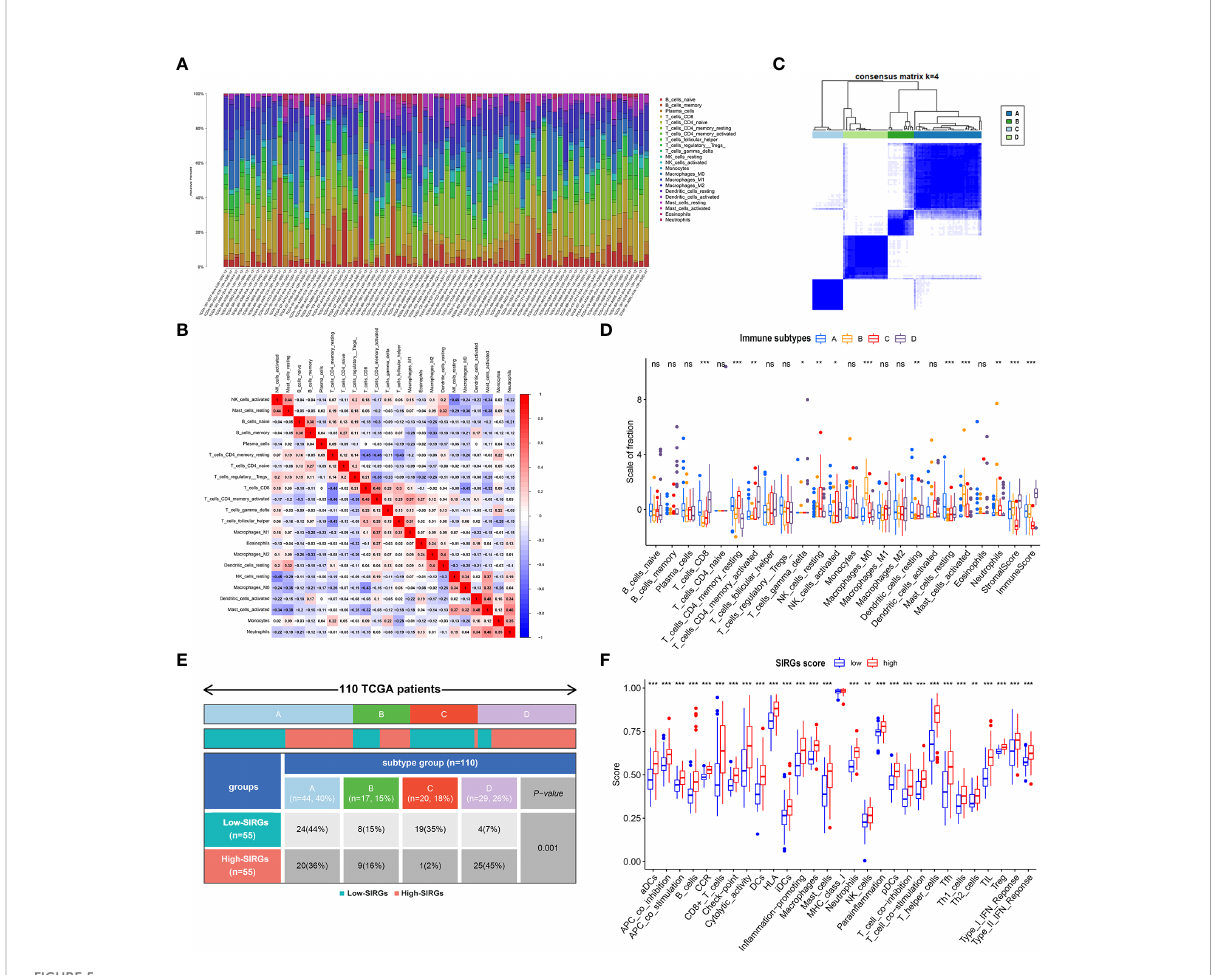
FIGURE 5 The difference TME in low- and high-SIRGs score group. (A) Relative proportion of immune in fi ltration in each EGJA patients; (B) The relationship in different immune in fi ltration cells; (C) Identify four immune subtypes by unsupervised clustering according to the immune in fi ltration state; (D) The difference in fi ltration immune cells in four immune subtypes; (E) The distribution of four immune subtypes in low- and high-SIRGs score group; (F) Immune-related functions analysis in in low- and high-SIRGs score group. *p<0.05, **p<0.01, ***p<0.001, ns, not signi fi